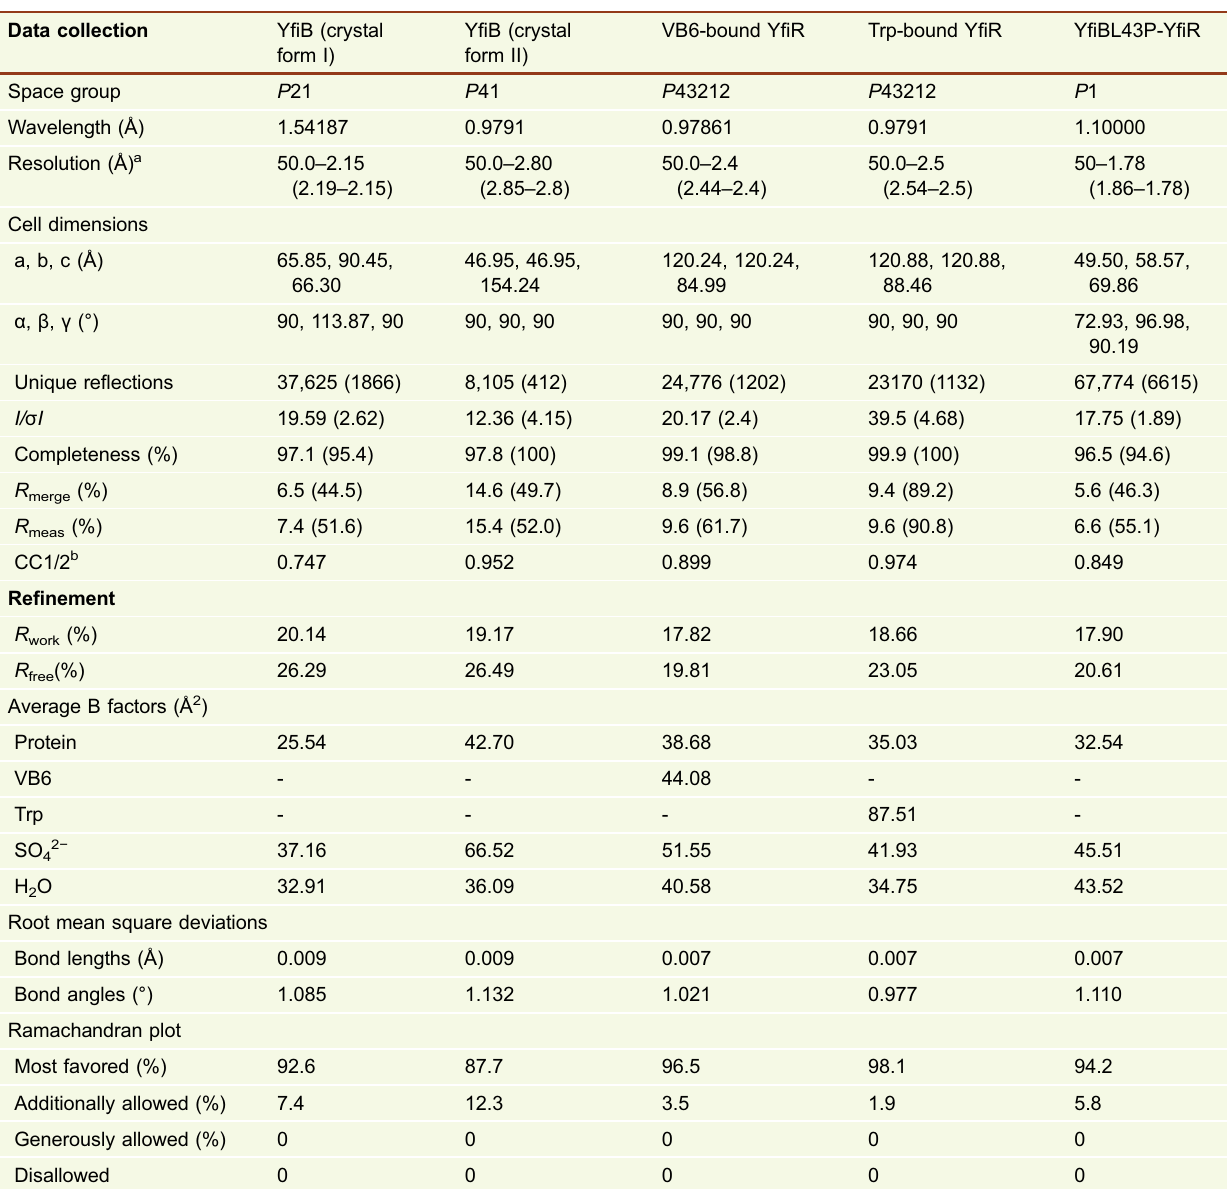
Table 1. Data collection, phasing and re fi nement